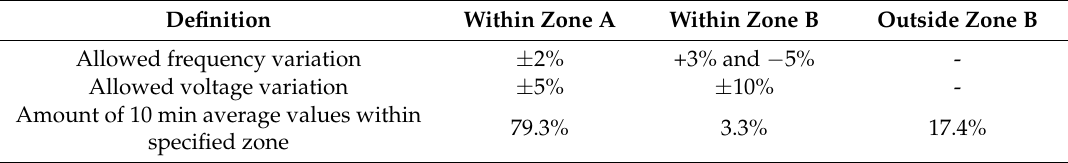
Table 2. Limits for each zone described in IEC Standard 60034-1 and the amount of time the nanogrid operated in each defined zone during islanded